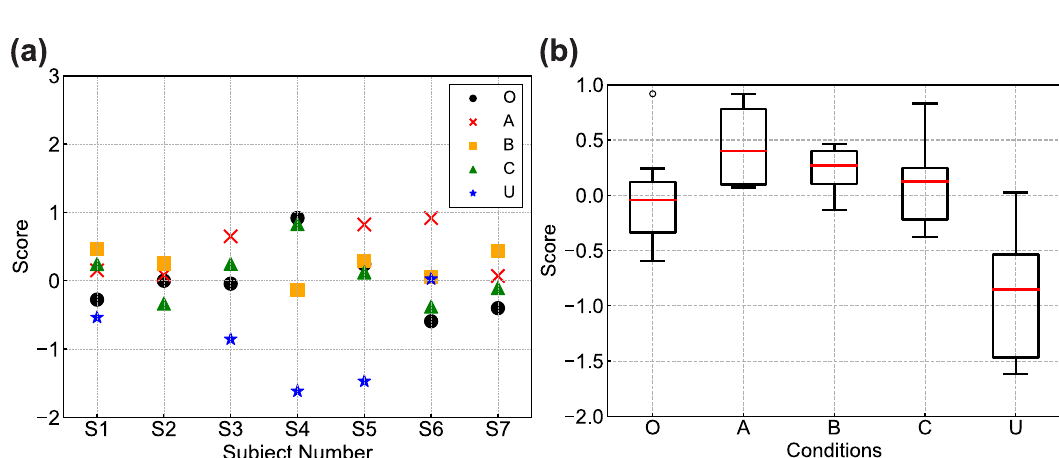
Fig 7. Individual results for evaluation values of the paired comparison in Experiment 3-2. (a) Individual results. (b) Box plot of the evaluation values between subjects. The data that are presented with a circle in the results for Algorithm O are shown as an outlier because they are more than 1.5 times the interquartile range from the third quartile. The original data are available in the Experiment 3-2 Table in the (S2